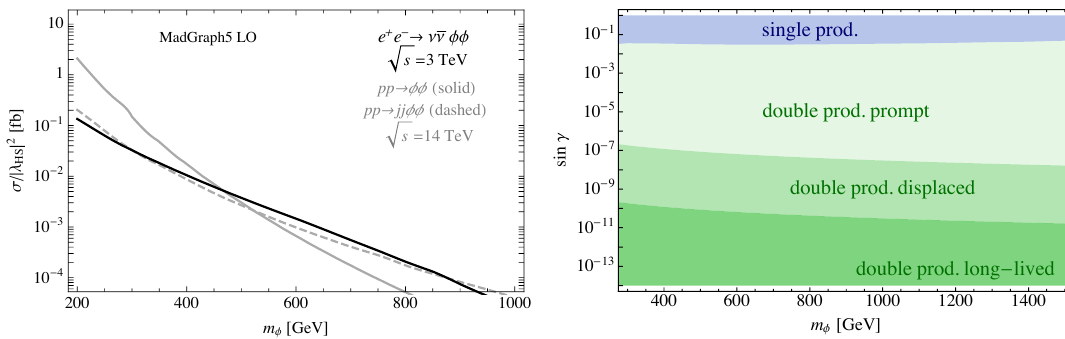
Figure 11. Left: pair production cross-section at the LHC and CLIC with normalisation (cid:21) HS = 1. Right: a cartoon of the parameter space of the singlet model as a function of the mixing and the mass. The di(cid:11)erent green regions correspond to di(cid:11)erent singlet decay lengths: prompt c(cid:28) < 0 : 1 cm, displaced 0 : 1 cm < c(cid:28) < 100 m and long lived c(cid:28) > 100 m. We also shown in blue the reach